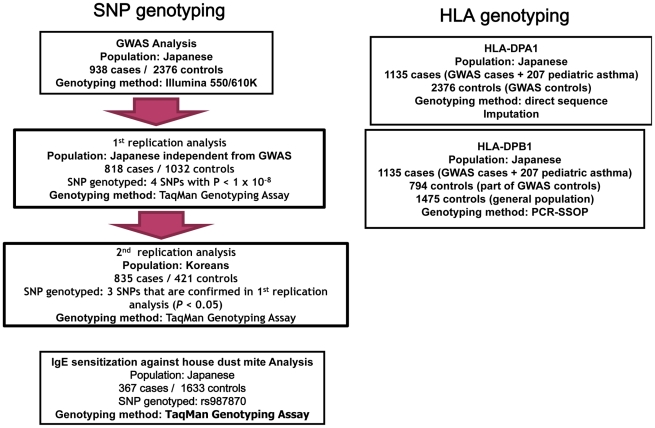
Flow chart of the present study.